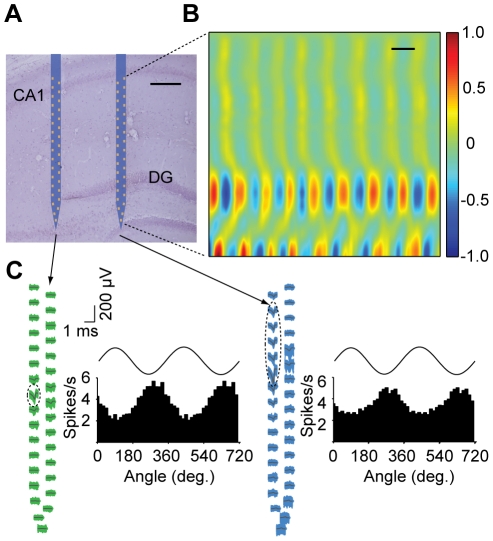
Electrophysiology with nanofabricated probes in awake behaving mice.(A) Nissl-stained brain section overlaid with a schematic of the probe at its stereotaxically implanted location. Each silicon shaft is 60 µm wide. Scale bar, 200 µm. (B) Current source density analysis of local field potentials across the hippocampus with a vertical resolution of ∼28 µm. Measurements correspond to the right-most shaft, which is co-localized with both the supra- and infra-pyramidal blades of the dentate gyrus (DG). The data were gathered during home cage exploratory behavior. The CSD is normalized to ±1. Scale bar, 100 ms. (C) Waveforms of two putative single units recorded from this probe across all sites on their entire respective shafts, with histograms showing theta phase locking of spikes. Dashed ellipses indicate the sites exhibiting the highest extracellular action potentials for these units. Measured theta oscillations on top of the histograms are for reference. Theta oscillations were measured from the upper right-most electrode near the CA1 pyramidal cell layer.